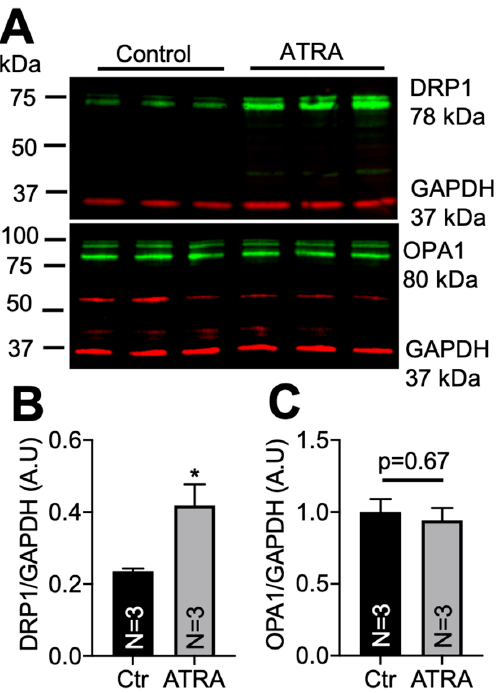
Figure 2. DRP1 and OPA1 levels in mouse hearts treated with an i.p. injection of ATRA or corn oil (vehicle control). ( A ) Western blots of DRP1 (upper panel) and OPA1 (lower panel). ( B ) DRP1 levels were significantly higher in ATRA-treated mice (* p < 0.05, vs. vehicle; unpaired 2-sample t -test). ( C ) There was no effect of ATRA on